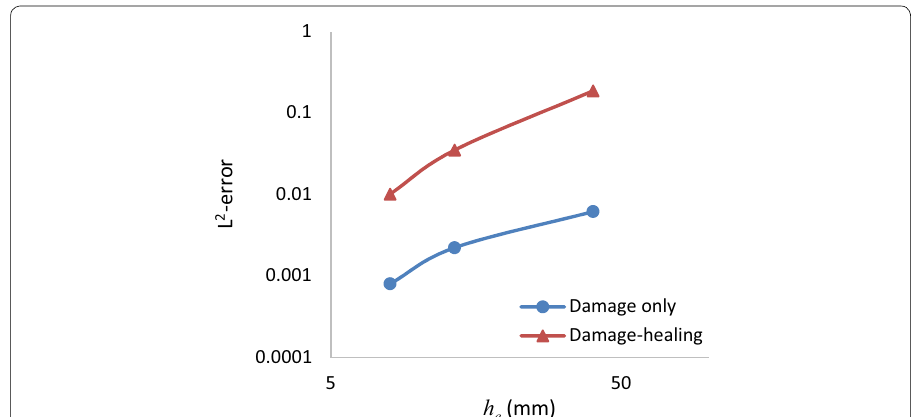
Fig. 6 Convergence in terms of the L 2 ‑error norm of the response curves